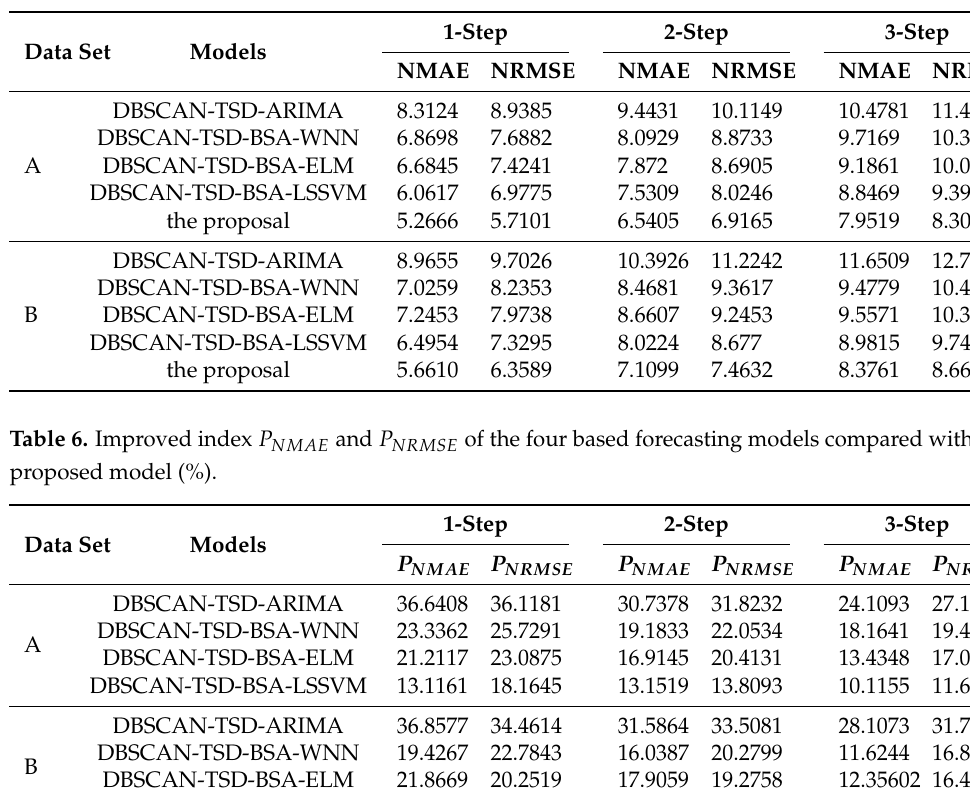
Table 5. Forecasting results obtained by individual models based on TSD and DBSCAN (%).